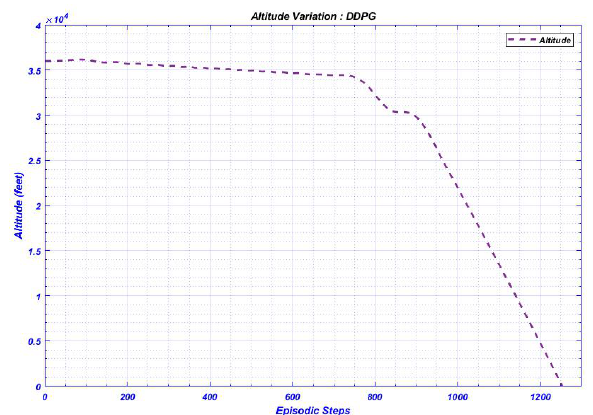
Figure 7. UAV Altitude variation.